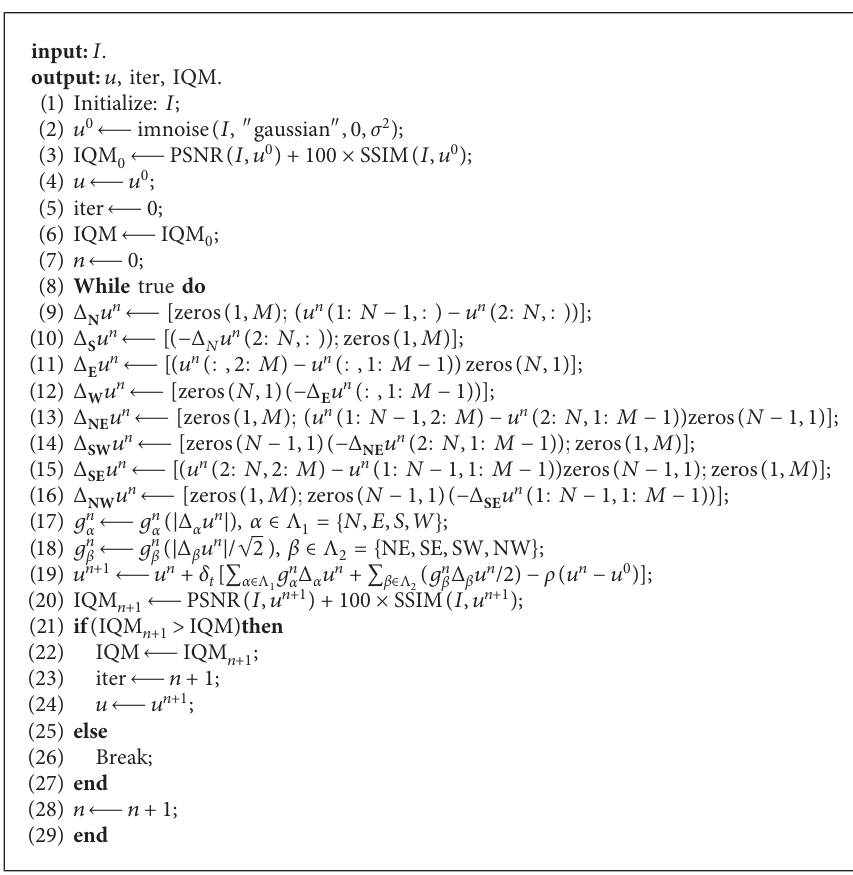
A LGORITHM 1: Proposed image denoising (Figure 1) and generate in it a Gaussian white noise with zero-mean and σ 2 -value, using the Octave built-in function “imnoise.” Next, the initial value u 0 is set to be the noisy